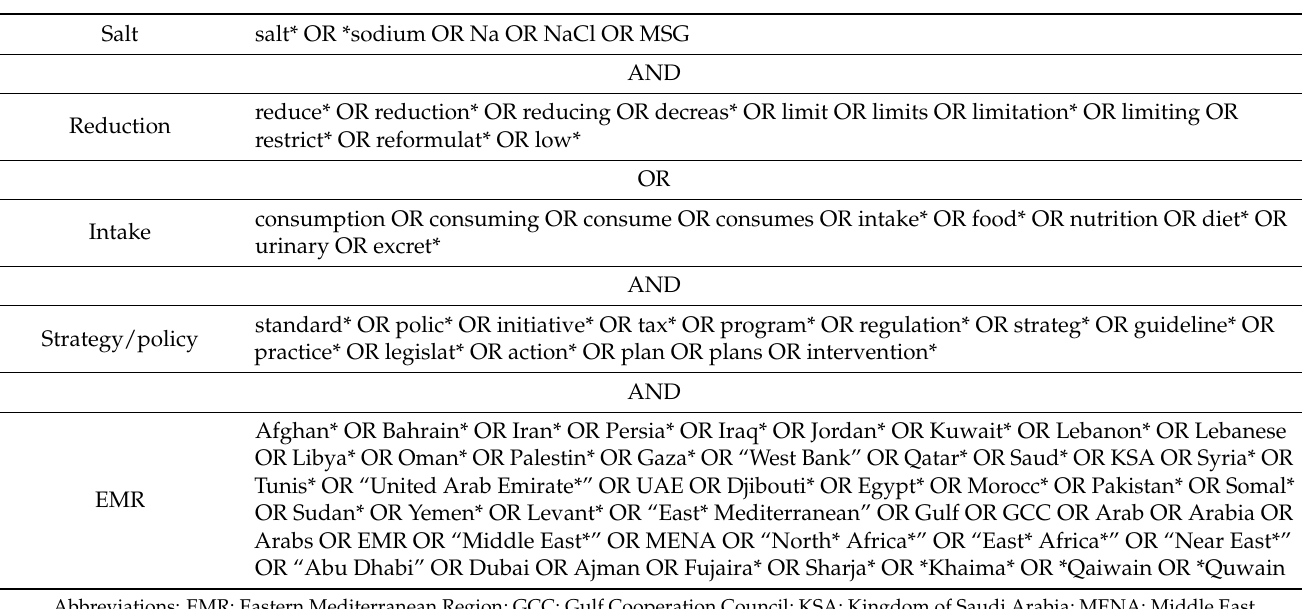
Table A1. List of Search